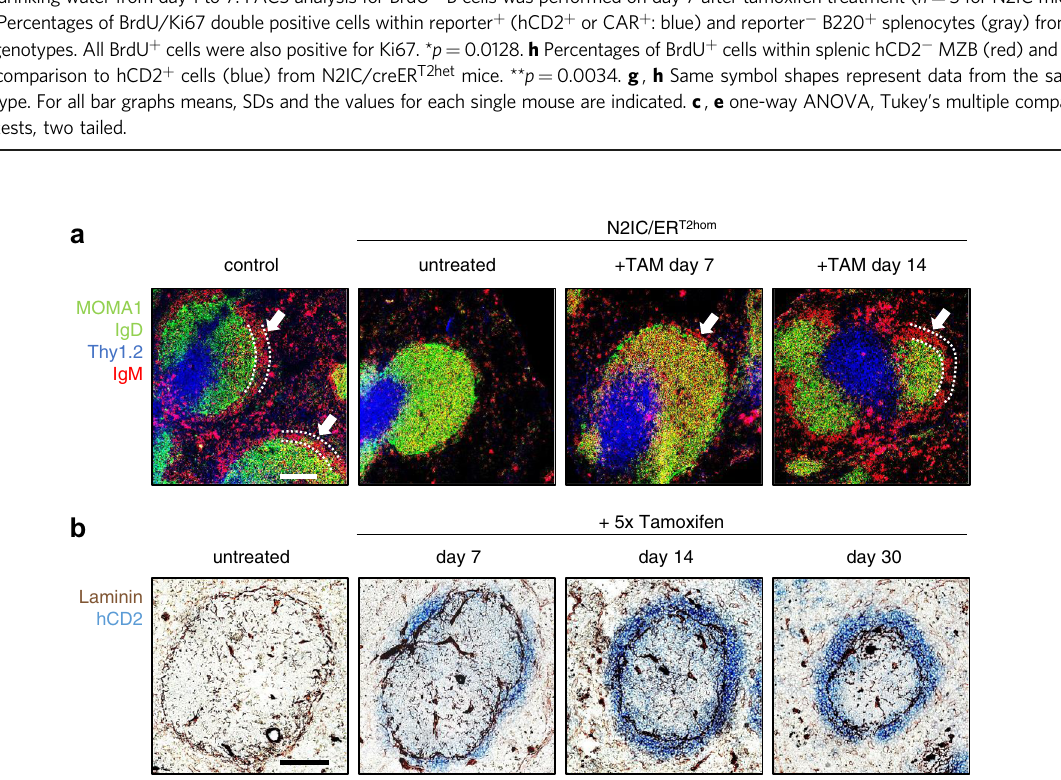
Fig. 2 Notch2IC-expressing cells progressively repopulate the marginal zone. a Immuno fl uorescence analysis of splenic sections from control and N2IC/ creER T2hom animals, with or without tamoxifen (TAM) treatment for the indicated time points. Sections were stained for FoB cells (IgD + , green), metallophilic macrophages (MOMA-1 + , green), T cells (Thy1.2 + , blue), and MZB cells (IgM ++ , red). MZB cells are highlighted by white arrows, the marginal zone is additionally delineated with dotted white lines. b Chromogenic immunohistochemical analysis for hCD2 expression after tamoxifen treatments. N2IC/creER T2hom mice were treated with 5 mg tamoxifen on 5 consecutive days. Indicated time points represent days after initial treatment. Notch2IC-expressing cells were stained for hCD2 (blue). The basement membranes of endothelial cells lining the MZ sinus and other blood vessels in the white and red pulp were stained by an anti-Laminin antibody (brown). The scale bars represent 100 µ m. Images are representative for splenic sections of 2 mice per